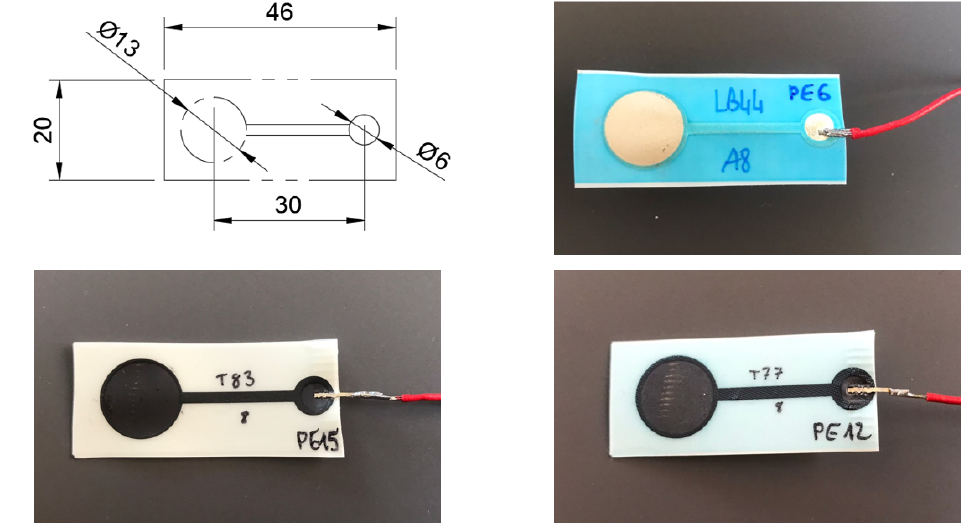
Figure 1. On the ( top ), from ( left ) to ( right ): electrodes’ dimensions in mm and silver electrode. On the ( bottom ), from ( left ) to ( right ): carbon and